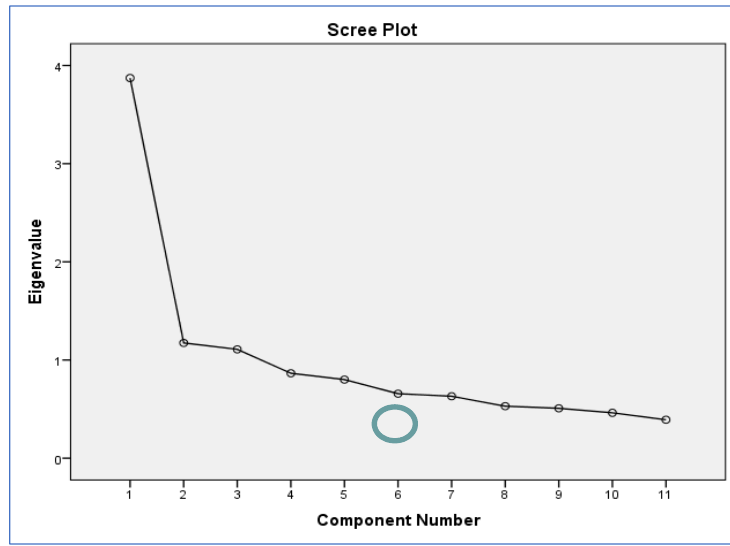
Figure 1. Eigenvalue scree plot.